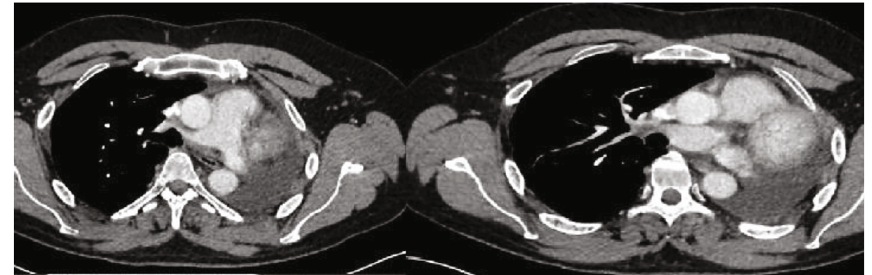
Figure 3: CT scan after left